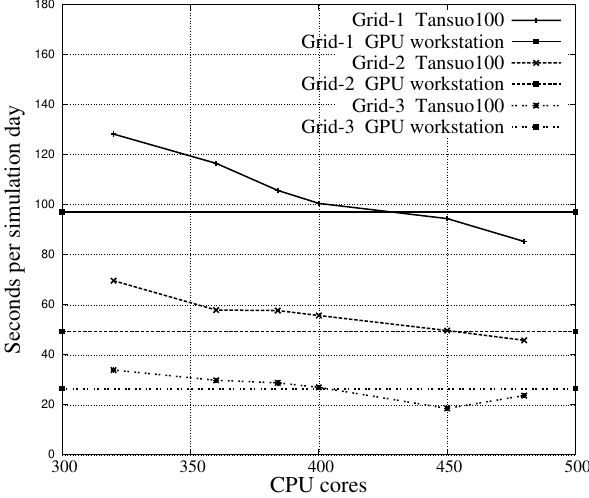
Figure 13. Performance test of four GPUs compared with the Tan- suo100